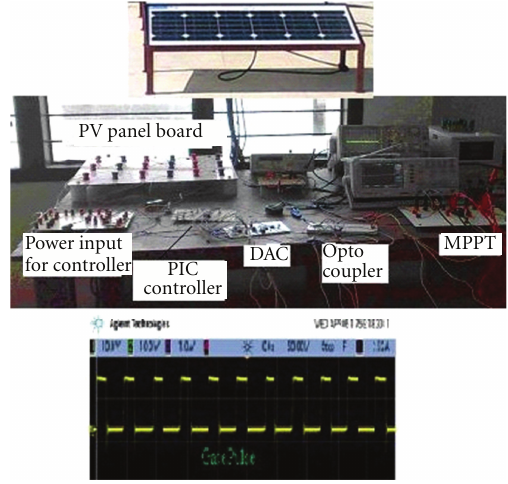
Figure 24: Hardware of MPPT.